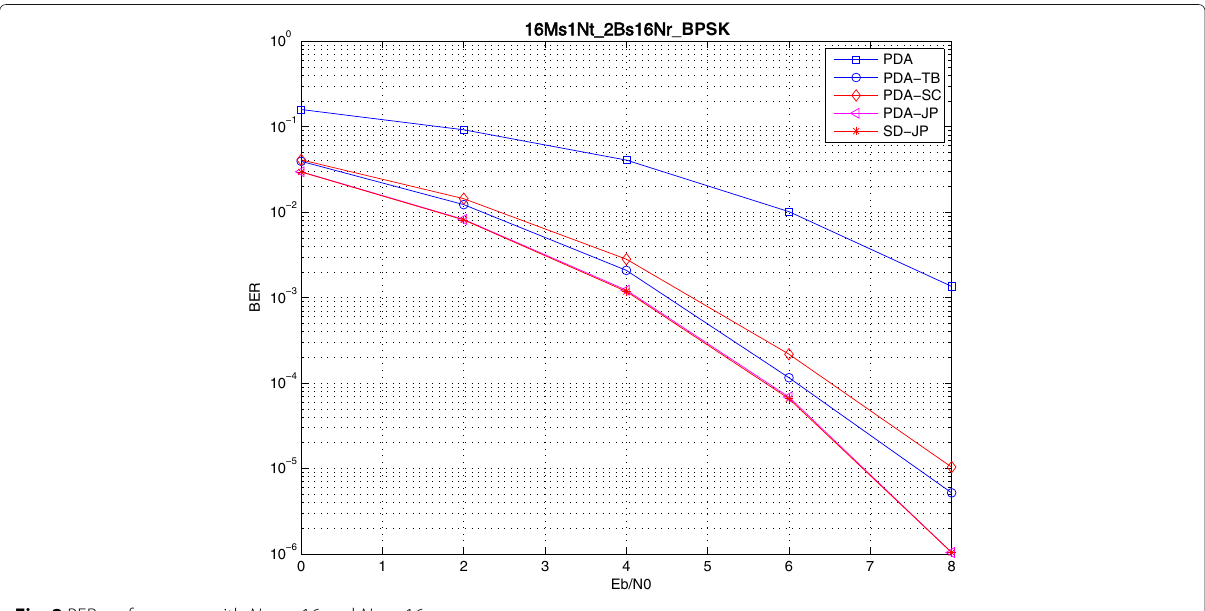
Fig. 2 BER performance with N m = 16 and N r = 16